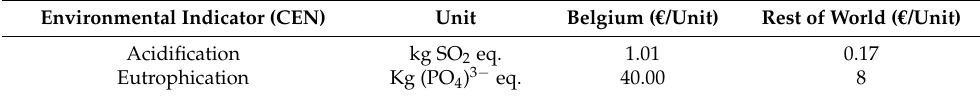
Table 3. Monetary indicators for CEN indicators. Environmental Indicator